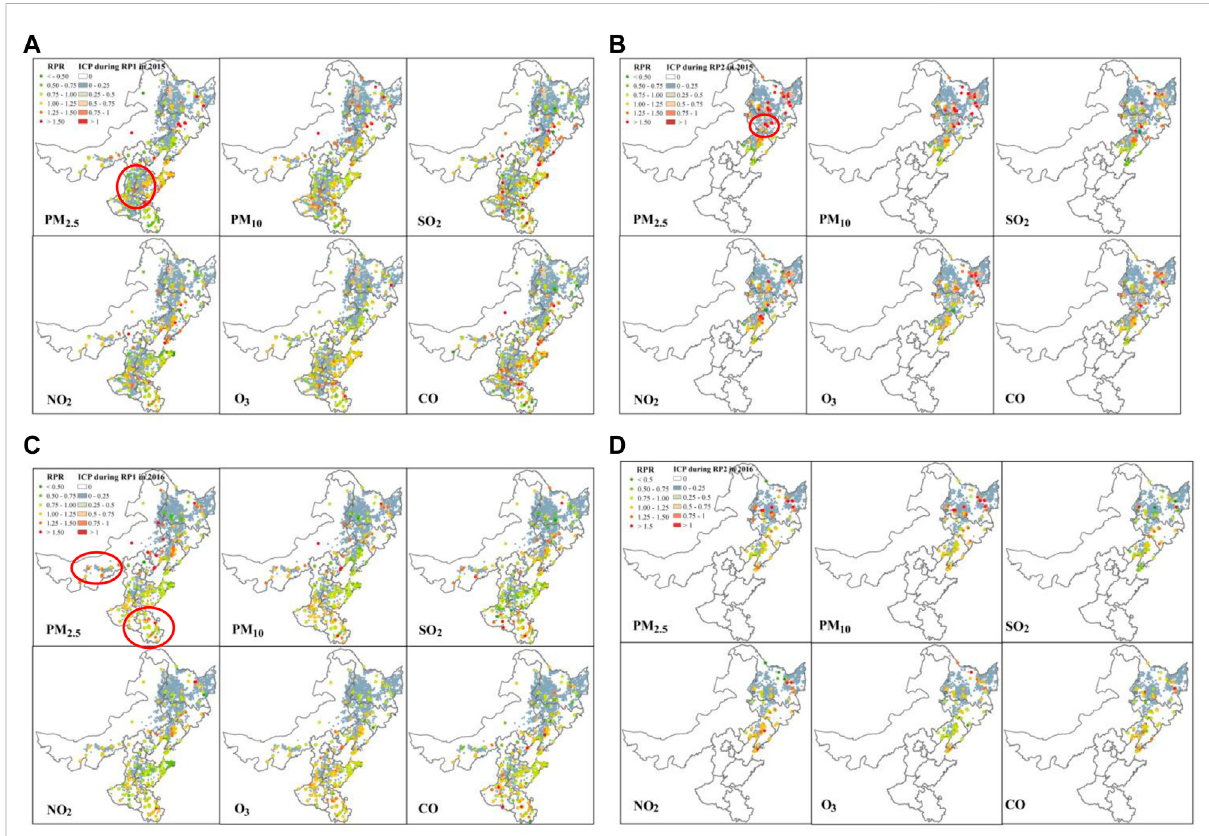
FIGURE 5 Spatial distribution ofRPRfor monitoring sitesindifferentPds: (A) HLJ-Pd1,JL-Pd1,LN-Pd1, IM-Pd, HB-Pd, SD-Pd, HN-Pd,andAH-Pdin2015, (B) HLJ-Pd2,JL-Pd2,andLN-Pd2in2015, (C) HLJ-Pd1,JL-Pd1,LN-Pd1,IM-Pd,HB-Pd,SD-Pd,HN-Pd,andAH-Pdin2016,and (D) HLJ-Pd2,JL-Pd2, and LN-Pd2 in